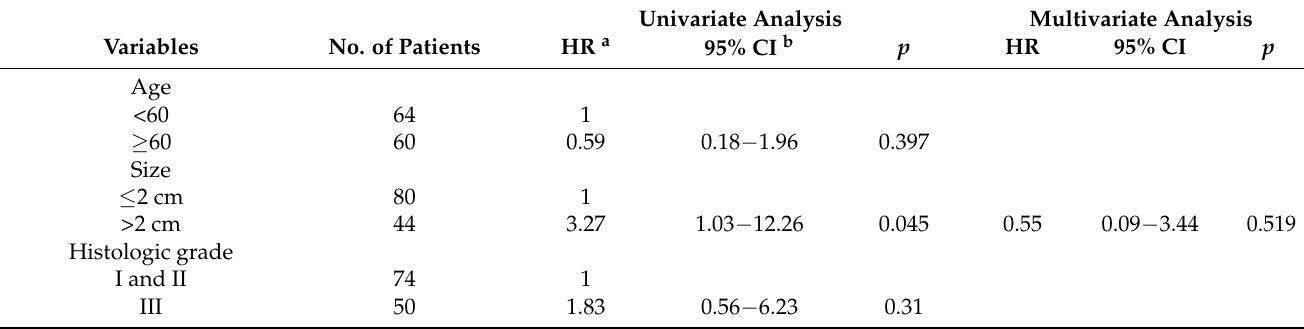
Table 2. Univariate and multivariate survival analyses for recurrence-free